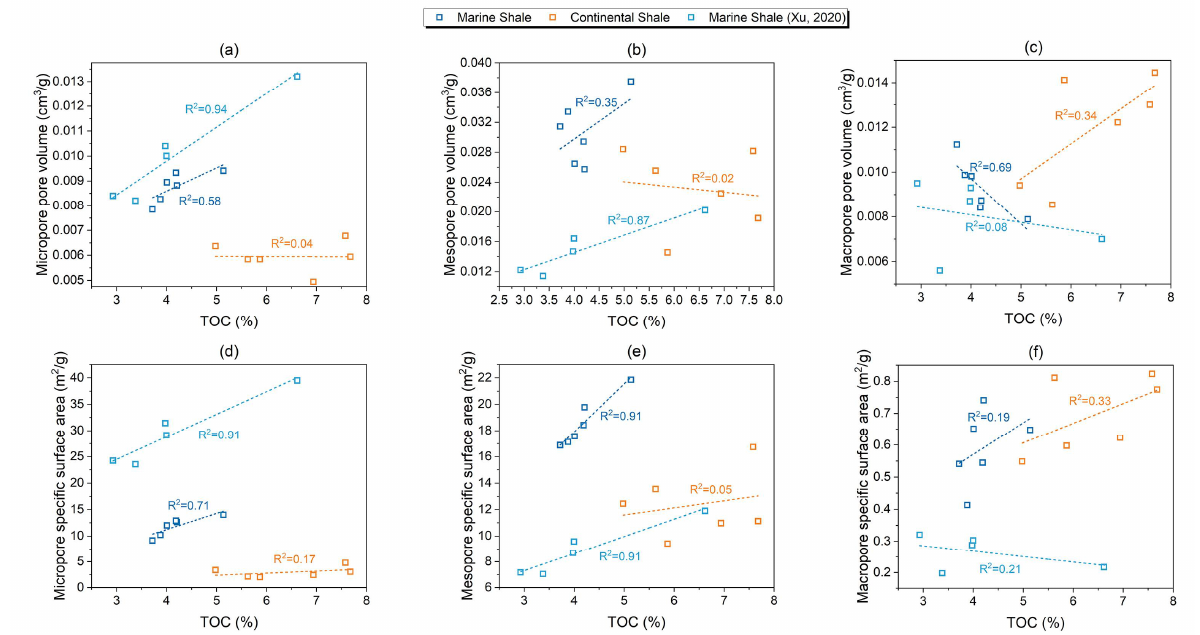
Figure 7. The correlation between the pore volume ( a – c ) of different pore sizes and TOC. The correlation between the specific surface area ( d – f ) of different pore sizes and TOC. Part of data from (Xu et al., 2020) [20].